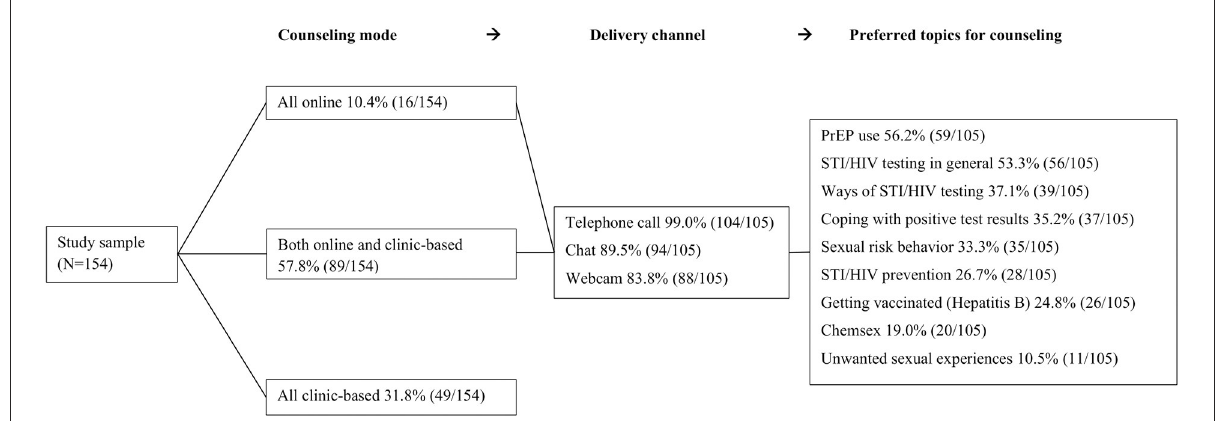
FIGURE2 Acceptability of online sexual health counseling among MSM who previously attended clinic-based sexual health care in the